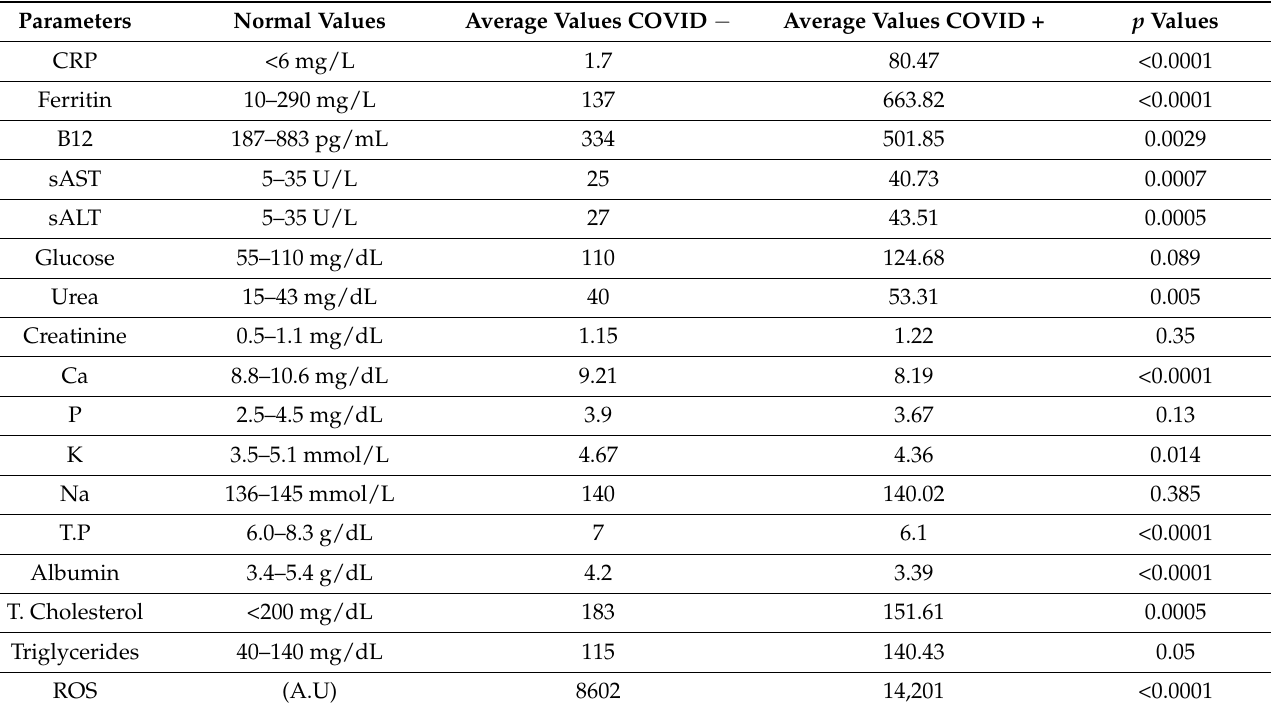
Table 3. Biochemical parameters between confirmed and suspected patients at the time of